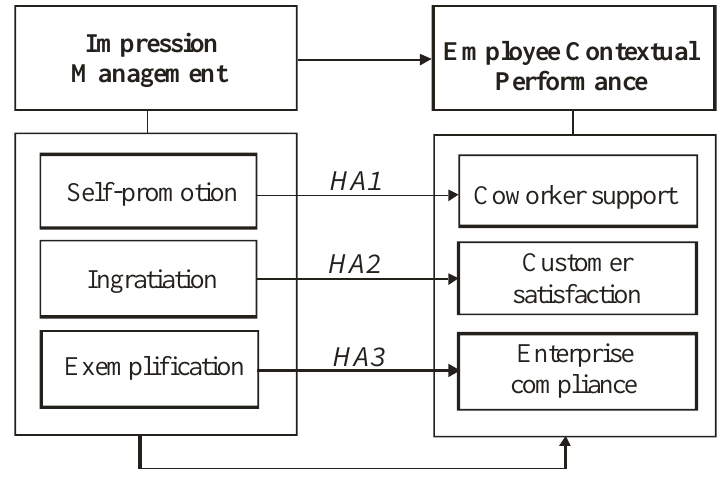
Figure 1. Conceptual